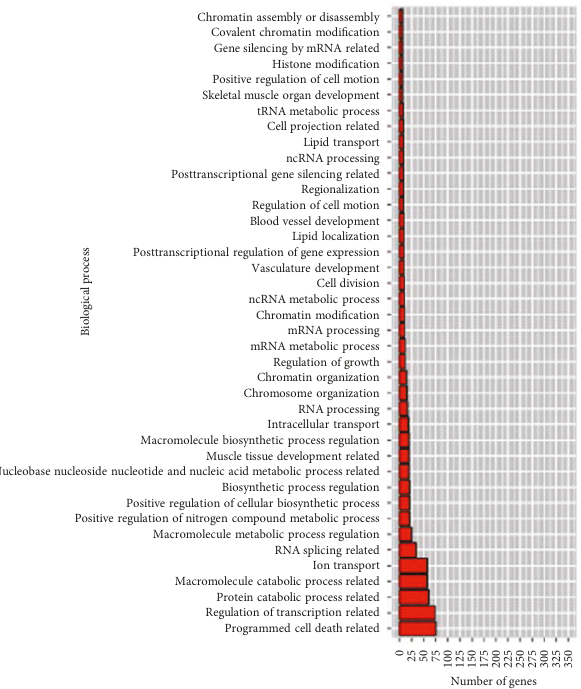
Figure 7: GO terms found for gene targets of upregulated miRNAs in response to F. tularensis exposure in hPBMCs. Programmed cell death is the top hit. Note that there are no downregulated miRNAs and thus no graphical